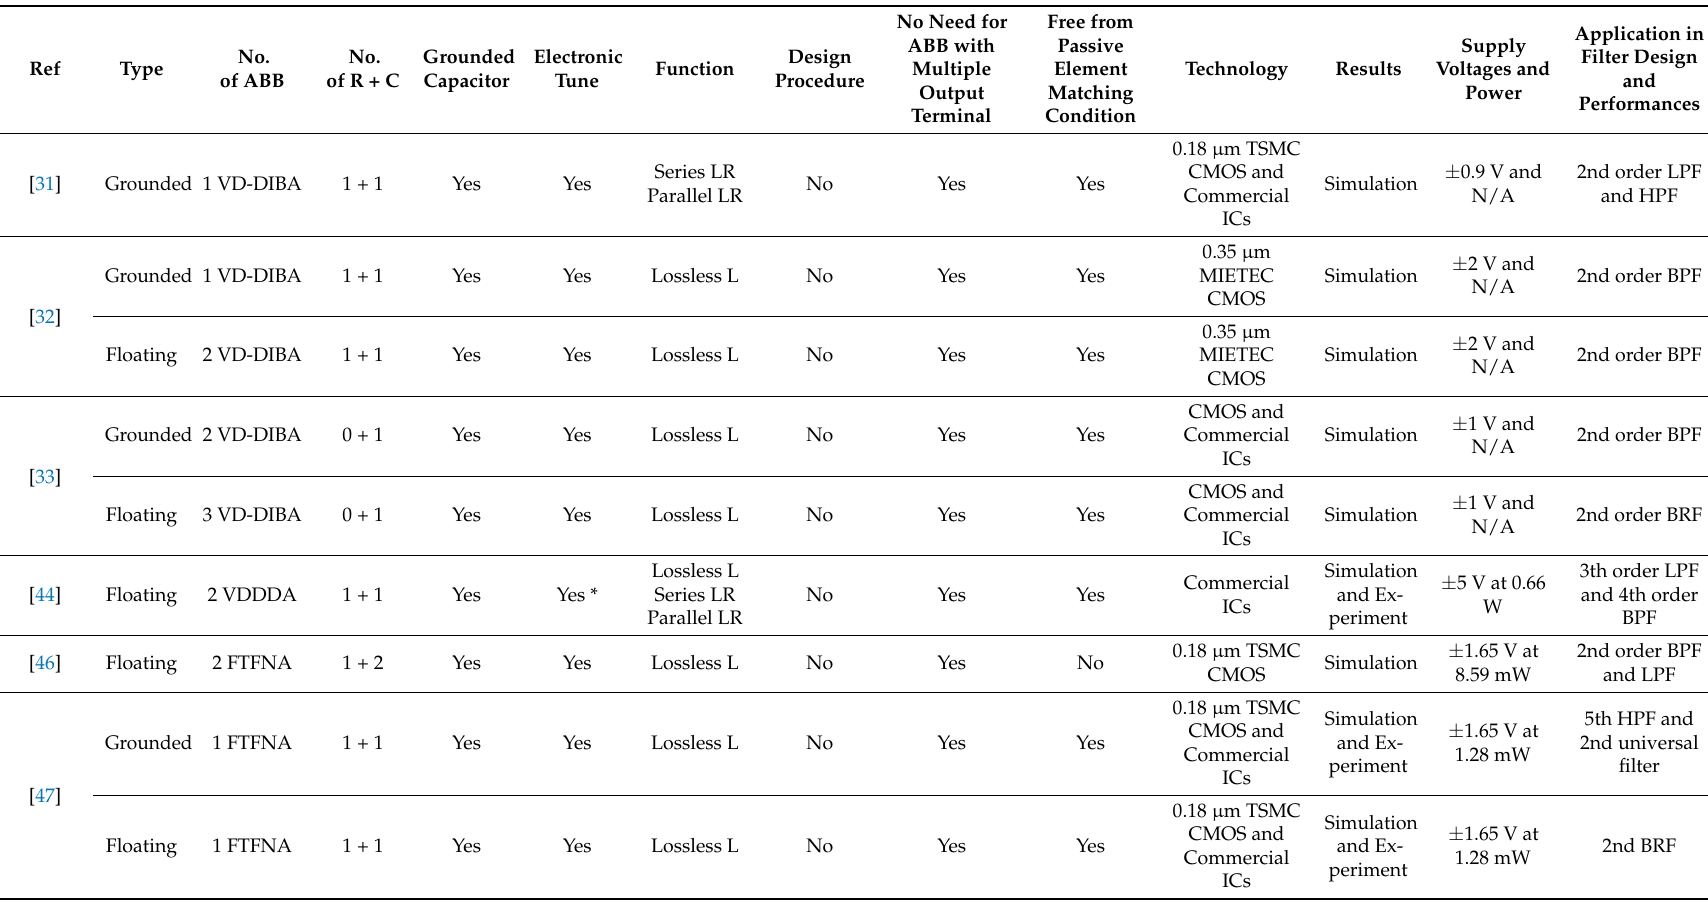
Table 3. Comparison of the proposed inductance simulators and other inductance simulators using an active building